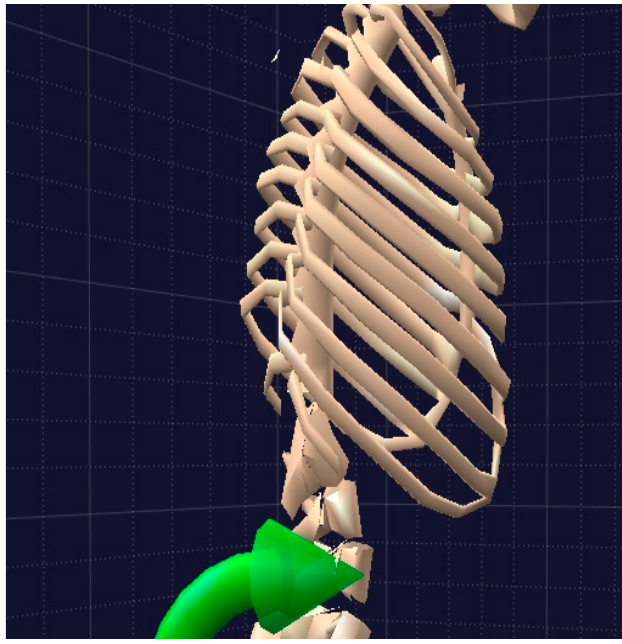
Figure 3. Sheer force at the L5 ‐ Pelvic junction represented by a 3D vector.